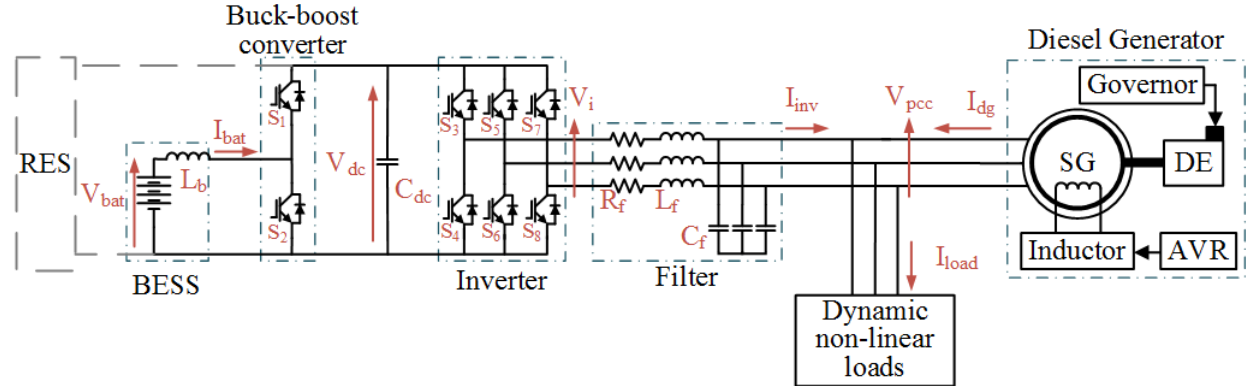
Figure 1. Standalone microgrid configuration under study.